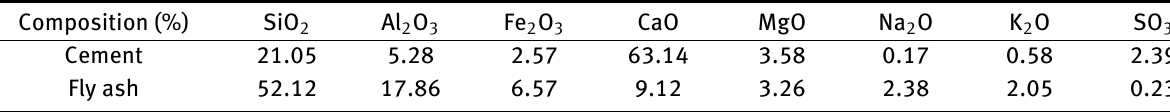
Table 2: Physical properties of PVA fiber Specific gravity